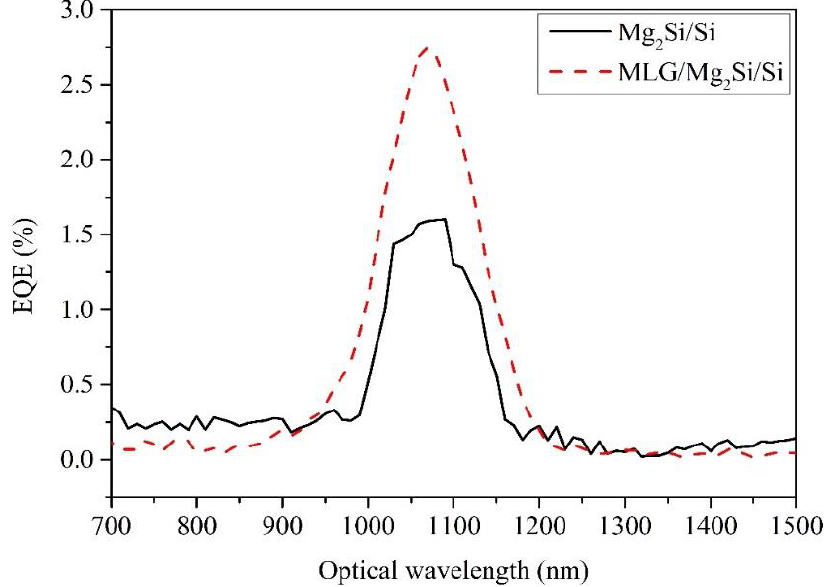
Figure 7. The EQE curves of Mg 2 Si/Si and MLG/Mg 2 Si/Si PDs.